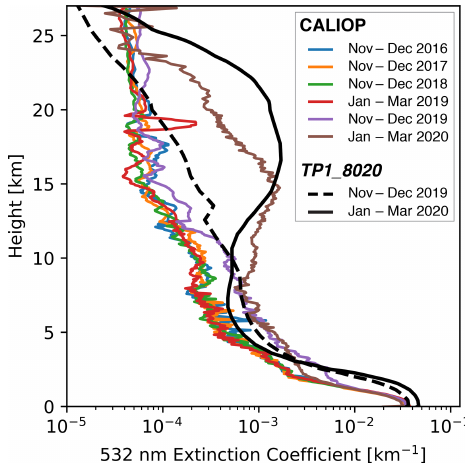
Figure 7. Mean vertical profile of the 532nm retrieved extinc- tion coefficient from CALIOP (colored lines) for several selected periods within 2016–2020 and the 2019–2020 results from the ECHAM6.3-HAM2.3 model for the TP1_8020 case, averaged over the area covering the latitudes and longitudes between 30 and 60 ◦ S and 145 ◦ E and 70 ◦